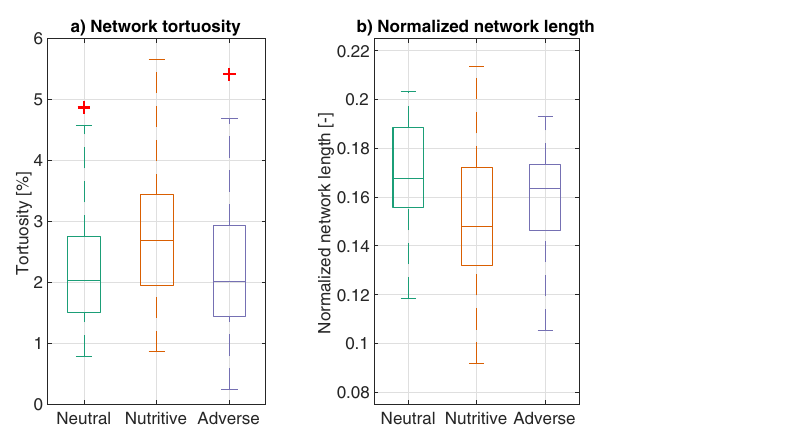
Figure 9. ( a ) Network tortuosity, computed by comparing the length of the network to the length of a network of equivalent topology but strictly straight segments between nodes. ( b ) Normalized network length, mapped to the interval [0 1], where the minimum spanning tree (MST) and Delaunay triangulation DT are the lower and upper bounds respectively. Box plots show median (horizontal line), interquartile range (box), distance from upper and lower quartiles times 1.5 interquartile range (whiskers), and outliers ( > 1.5 x upper or lower